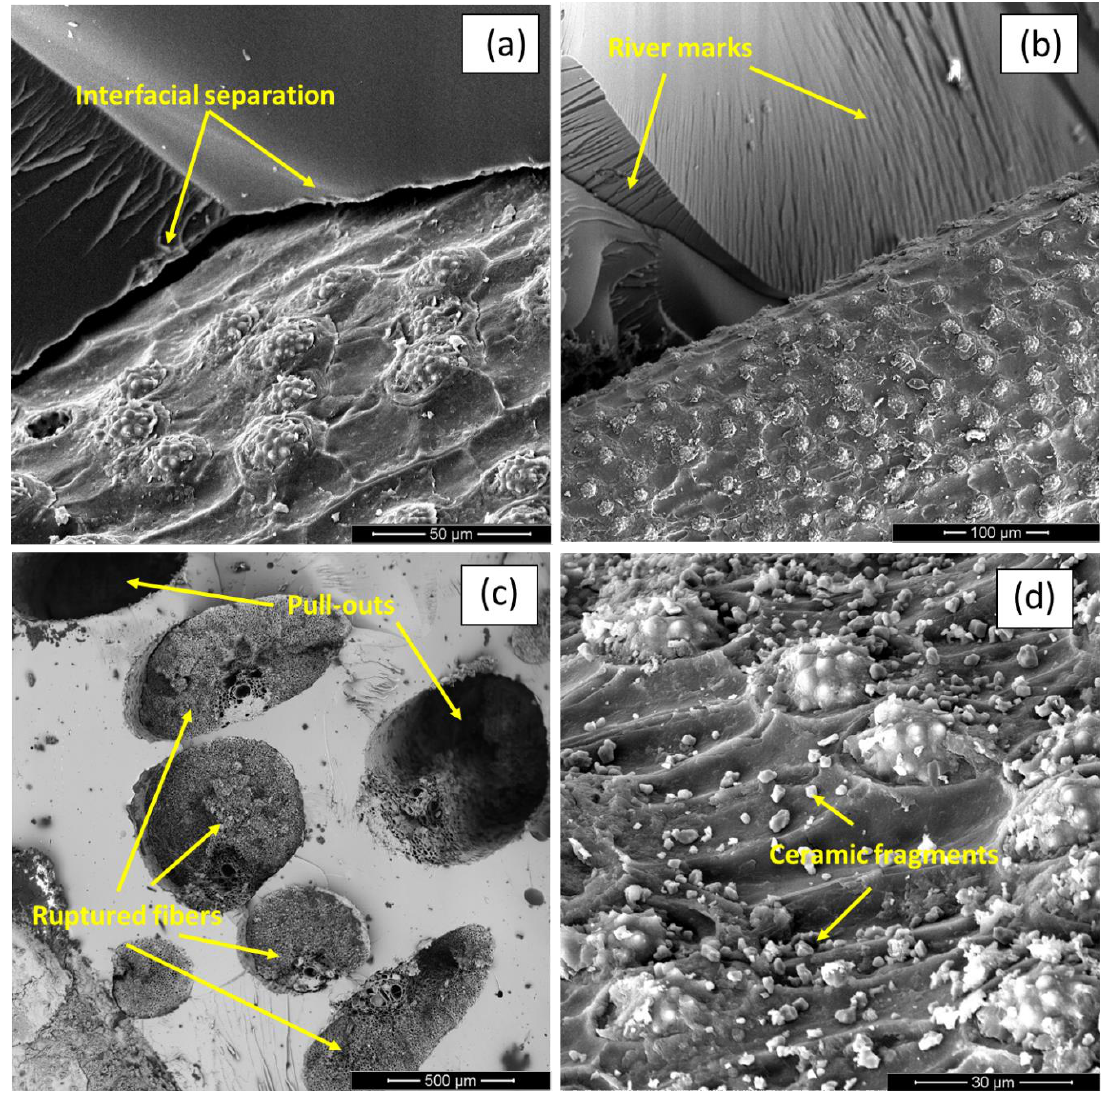
Figure 8. SEM of failure micro mechanisms associated with ballistic impact ( a ) fiber/matrix separation; ( b ) brittle characteristic of epoxy matrix; ( c ) pullout and fiber breakage, and ( d ) ceramic incrustation on surface of piassava fiber.